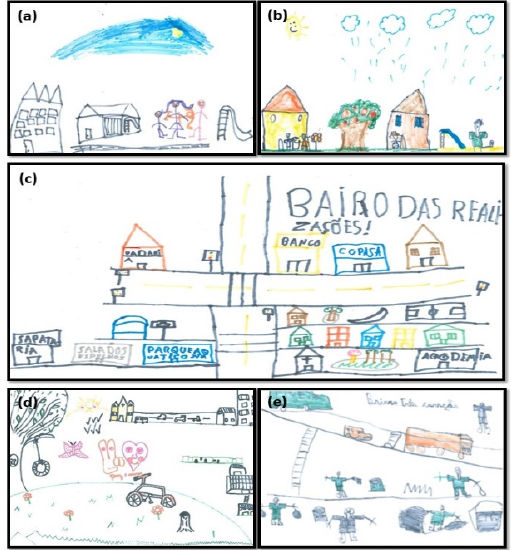
Figure 1. Representative drawings of the Quality of Life (QoL) neighborhood, Brazilian children, aged 6–10 years, urban area. ( a ) C1-S4: 6-year-old boy, ( b ) C4-S3: 7-year-old boy, ( c ) C6-S5: 8-year-old boy, ( d ) C7-S1: 9-year-old boy, ( e ) C8-S3: 9-year-old-boy. C: child; S: school.